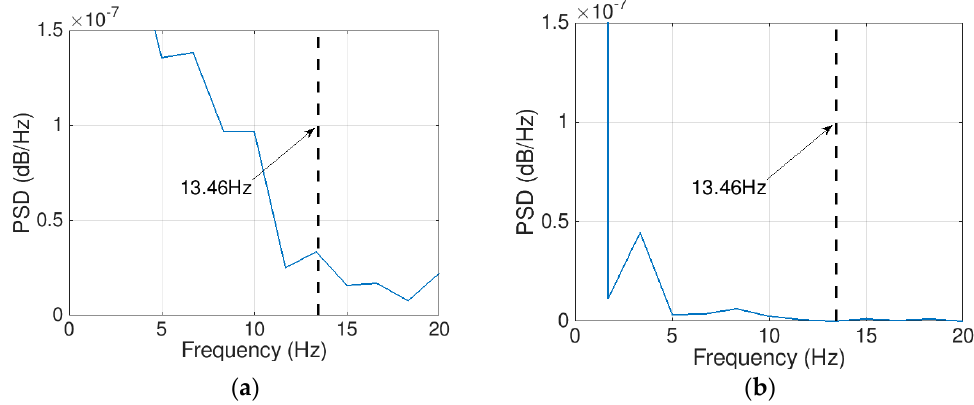
Figure 14. PSD plots for the contact point displacement history of the quarter car: ( a ) roughness is defined using a 2.5-cm increment ( b ) roughness is defined using a 25-cm increment.